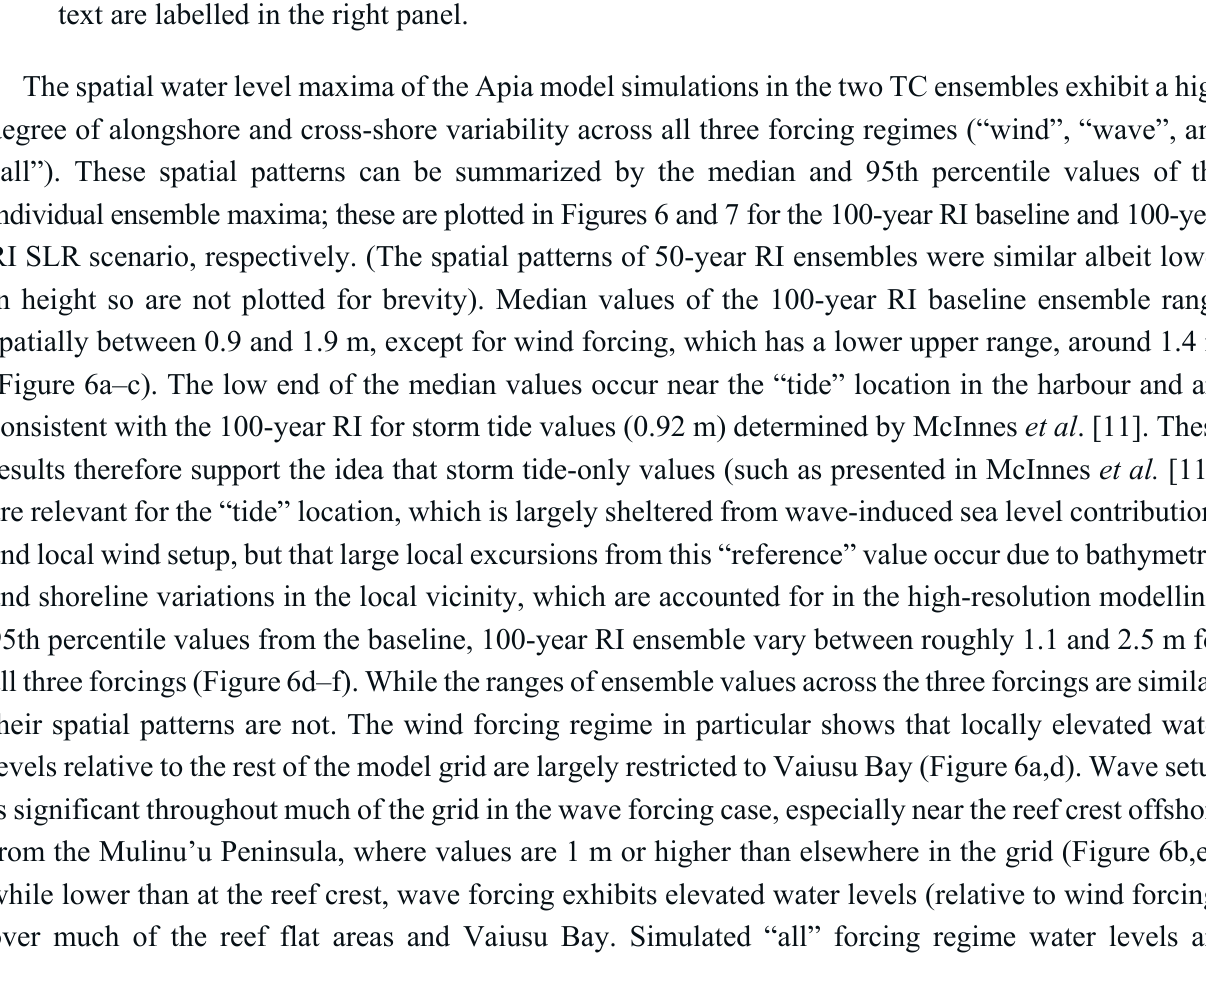
Figure 5. Apia Model output near the peak of local water levels during Cyclone Ofa. ( Left panel ): significant wave height and peak wave direction ( grey arrows ). ( Right panel ): water levels and depth-averaged current vectors ( grey arrows ). Locations discussed in the text are labelled in the right